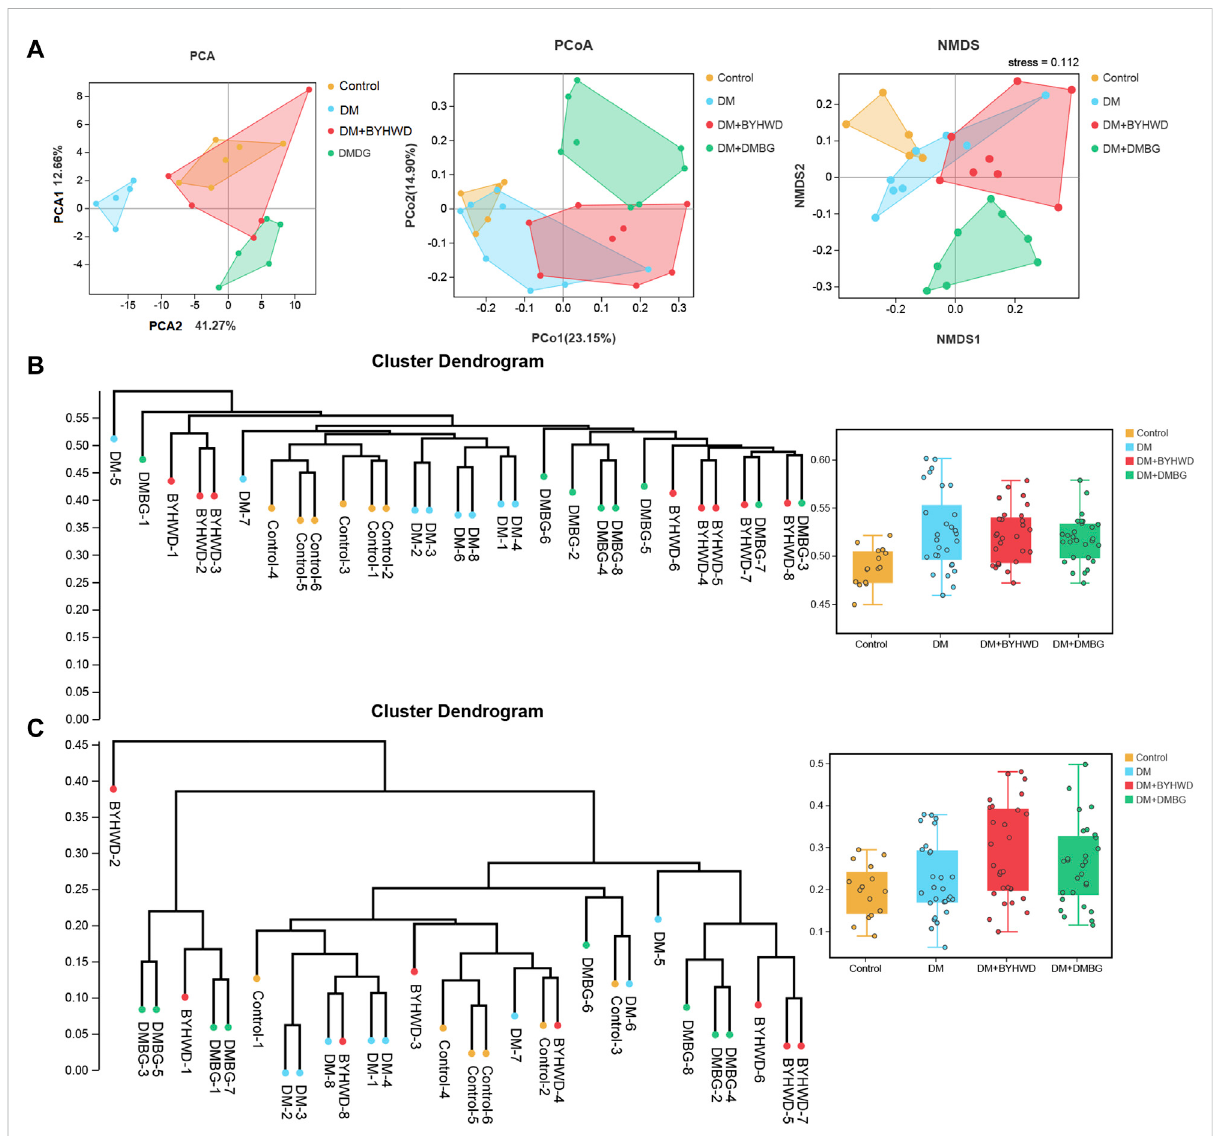
FIGURE 5 Spearman ’ s correlations among the pharmaceutical factors, the differential lipid metabolites, and the gut microbiome in diabetic ZDF rats after BYHWD treatment: (A) associations between the pharmaceutical factors and the differential lipid metabolites; (B) upper panel exhibits the associations between the pharmacological factors and the gut microbiome at the phylum level, while the lower panel displays the associations betweenthedifferentiallipidmetabolitesandthegutmicrobiomeatthephylumlevel; (C) theupperpanelexhibitstheassociationsbetweenthe pharmacological factors and the gut microbiome at the genus level, while the lower panel displays the associations between differential lipid metabolites and the gut microbiome at the genus level. The magnitude of the correlation is represented by the color intensity (blue, negative correlation; red, positive correlation), and the asterisks (*) in correlation heatmaps indicate p <